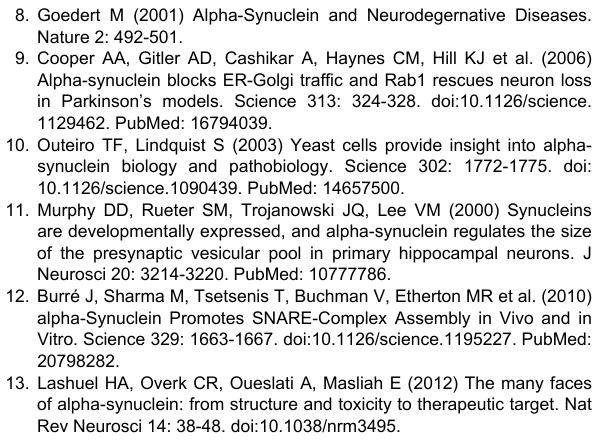
Figure S1. SSP overlay of Ac-WT, Ac-A53T, WT, and A53T. The SSP values for the full-length A53T (blue), Ac-A53T (red), WT (black) and Ac-WT (green) are displayed per residue. (TIFF) Figure S2. 15 N HSQC of the non-acetylated A53T and WT. The A53T mutant is indicated by blue, and the WT by black. The few places they do not overlay are near the site of the A53T mutation.